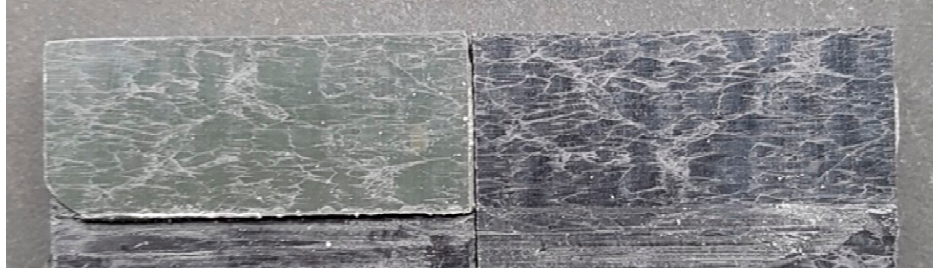
Figure 8. Fracture surface of the degreased specimen subjected to the quasi-static tensile test.